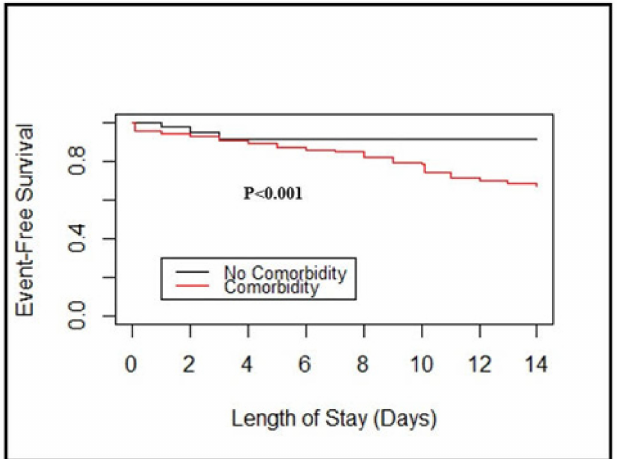
Figure 1. Event-free survival curves by comorbidity based on the Kaplan–Meier method. Statistical significance was calculated using a two-sided log-rank test.